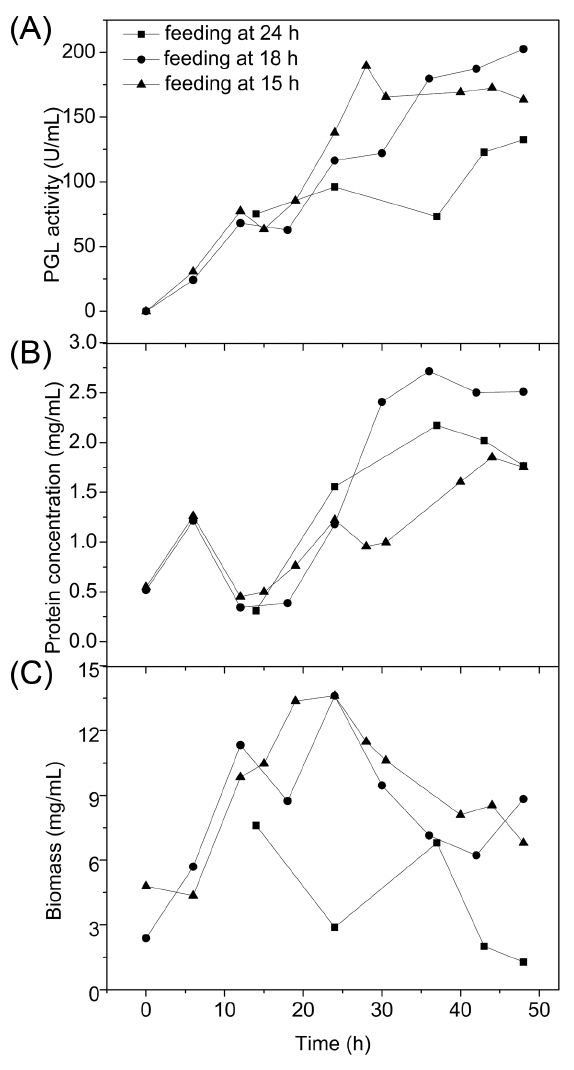
Figure 4. Effect of feeding time on PGL activity (A), protein concentration (B), and biomass (C) in a 7.5 L fermentor.